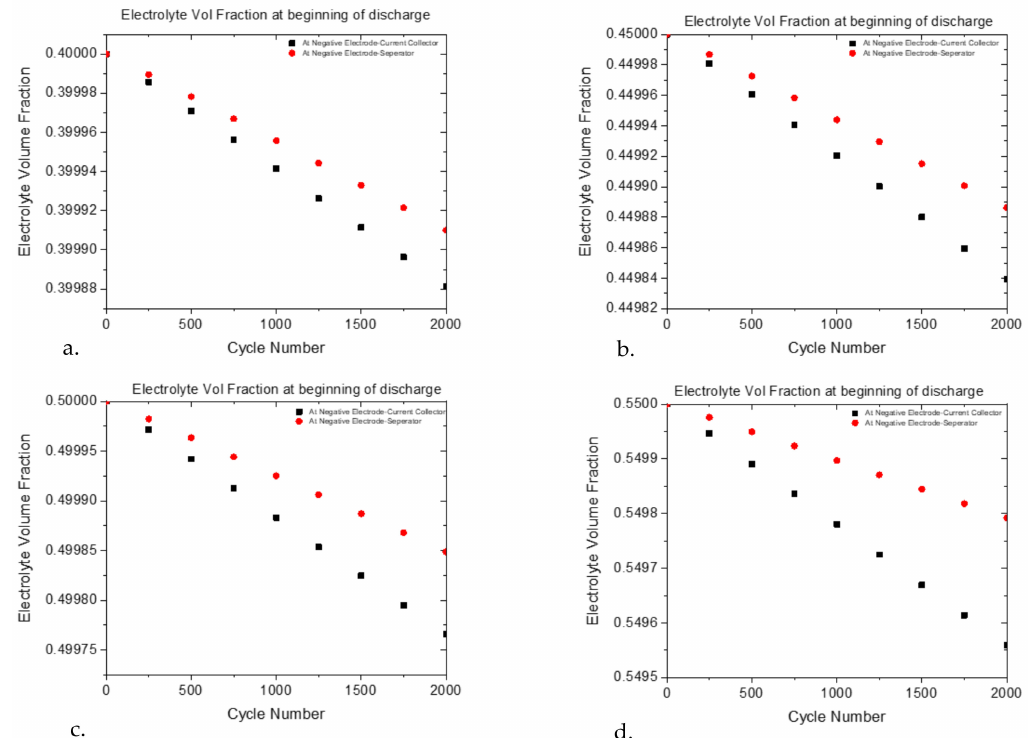
Figure 4. Simulated Electrolyte volume fraction at the two boundaries of the negative electrode at the interfaces with the current collector and the separator for porosity values of ( a ) 0.40; ( b ) 0.45; ( c ) 0.50; ( d )